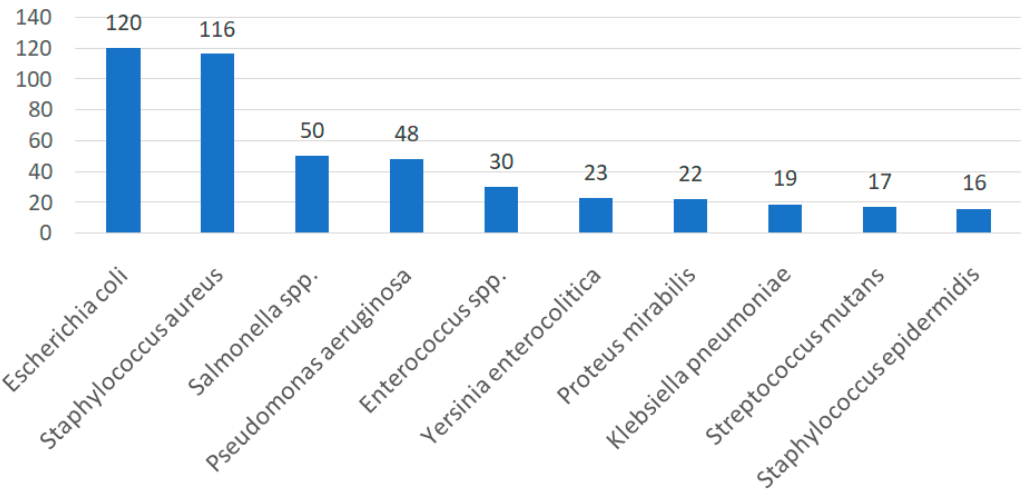
Figure 6. A number of studies with the ten most-analyzed bacterial strains in terms of sensitivity to propolis extracts.